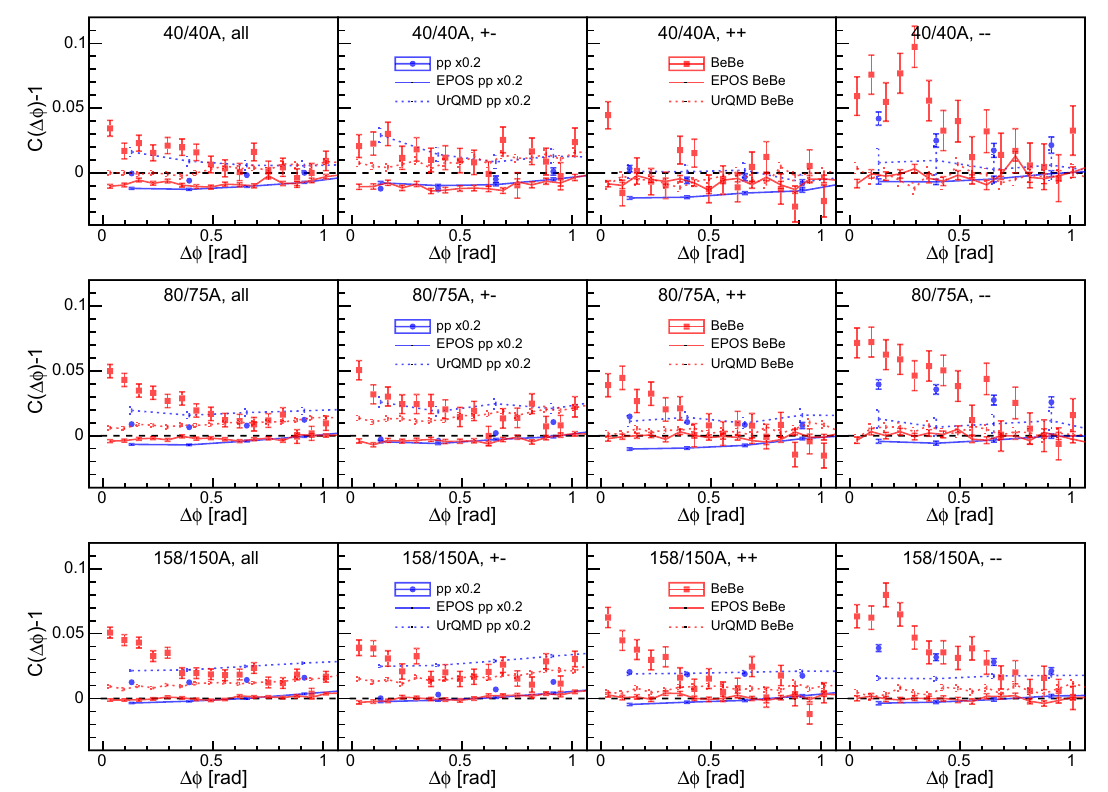
Fig. 13 Comparison of two-particle correlation function C − 1 for the range (cid:2)η ∈ [ 0 , 0 . 5 ) and for zoomed in range of 0 ≤ (cid:2)φ ≤ 1 radians. Results of collisions of p + p are marked in blue and of Be + Be are marked in red. Columns from left to right show results for: all charge pairs, unlike-sign pairs, positive pairs, and negative pairs. Results for beam momenta 40 A , 75 A , and 150 A GeV / c are plotted in successive